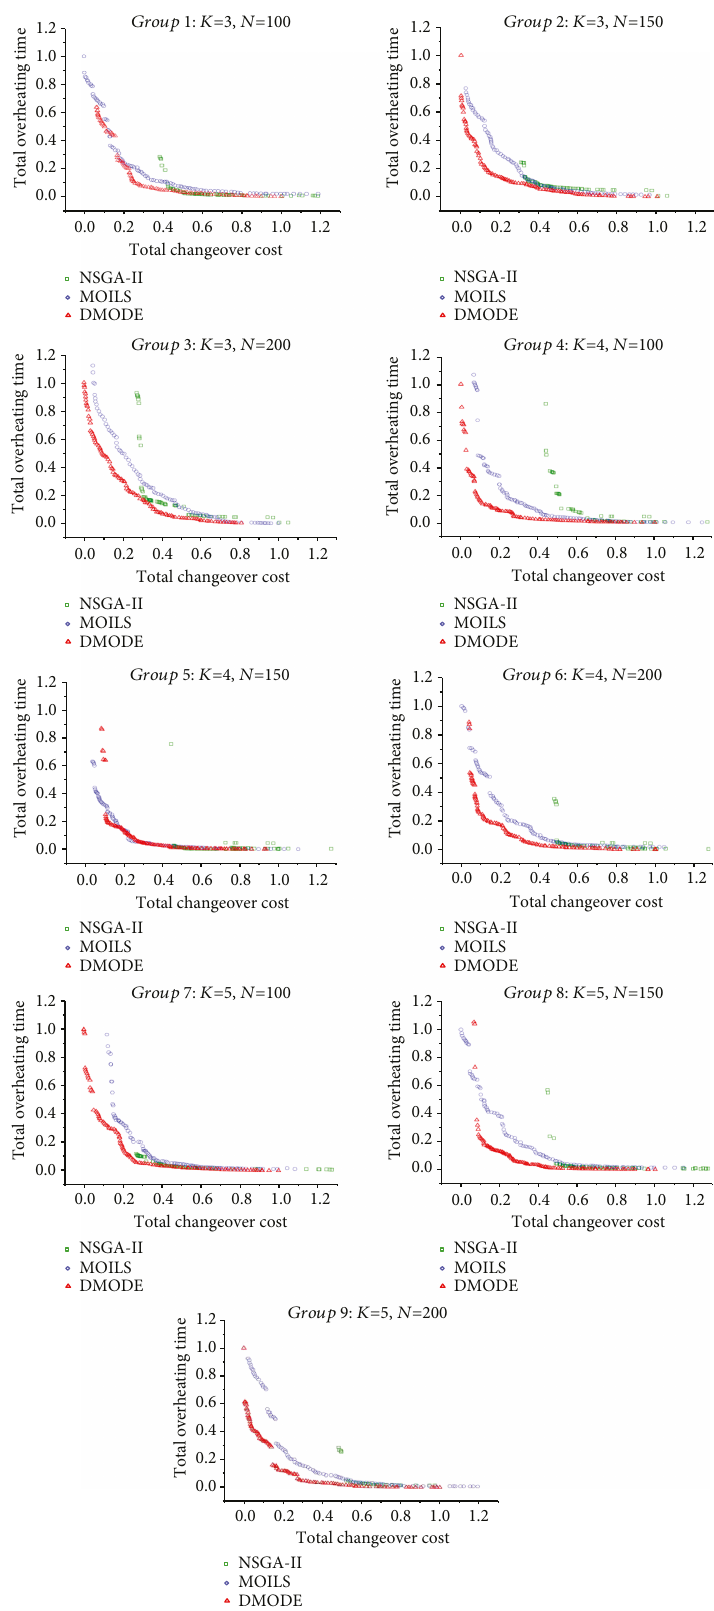
Figure 11: Pareto front obtained by NSGA-II, MOILS, and